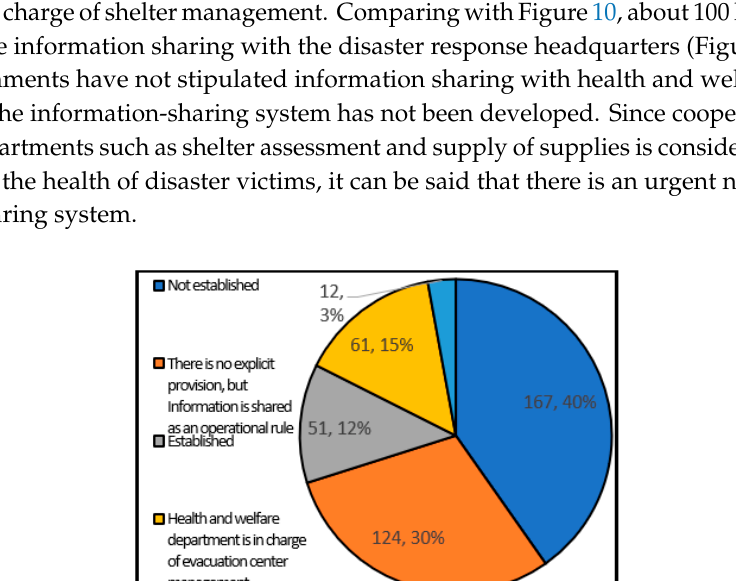
Table 3. Issues related to shelter management.